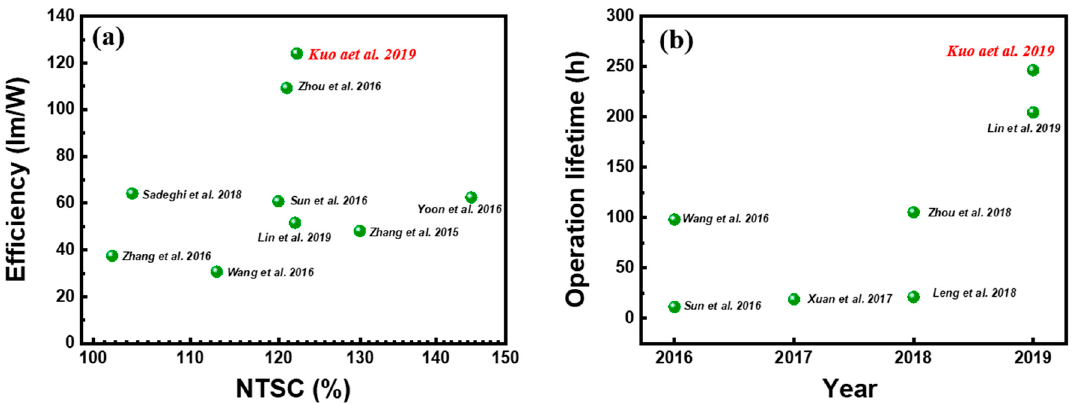
Figure 15. Comparison of device performance between PQD paper-based LED and other reported LEDs using QDs as color converters. ( a ) Luminous efficiency and color gamut performance and ( b ) operational durability of reported QD-based LEDs [78]. Figure reproduced with permission from John Wiley and Sons.